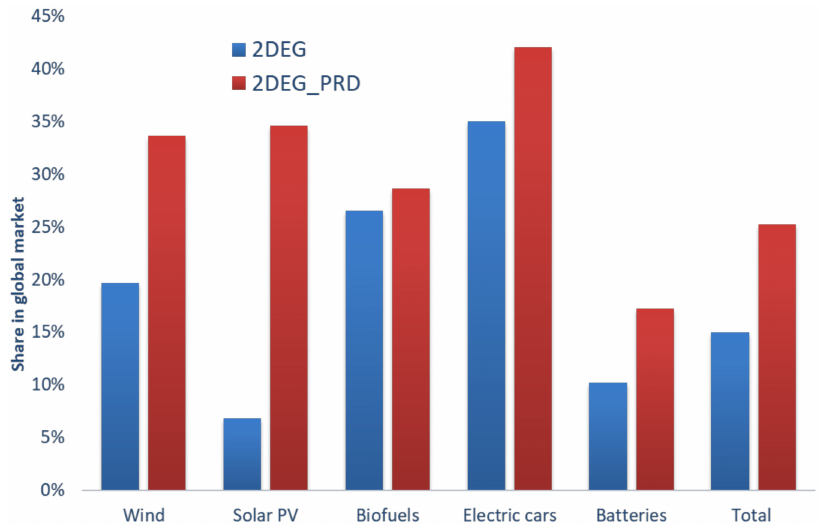
Figure 9. EU share in global low-carbon market (cumulative over